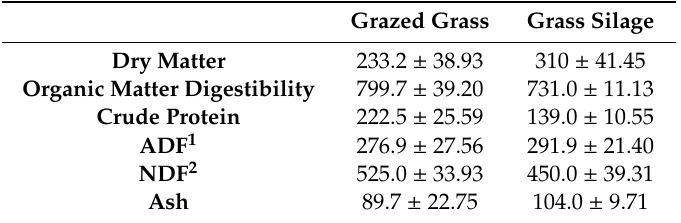
Table2. Chemicalcomposition(g / kgofdrymatter(DM);mean ± standarddeviation(SD)andnutritional content of the grazed grass and grass silage collected weekly throughout the experimental